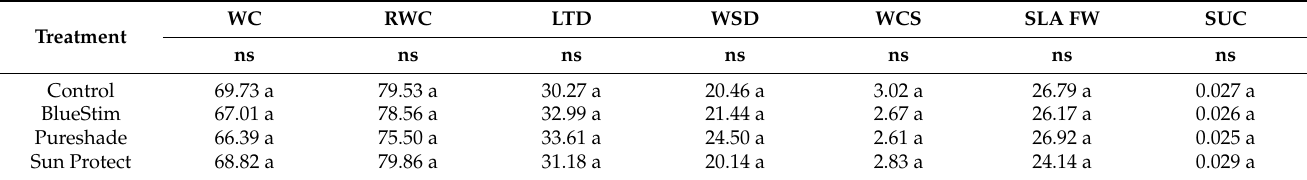
Table 2. Effects of alleviating products on kiwifruit leaf sclerophylly indexes during the second sampling event on August 20th (WC, %; RWC, %; LTD, g kg − 1 ; WSD, %; WCS, g H 2 O g − 1 DW; SLA